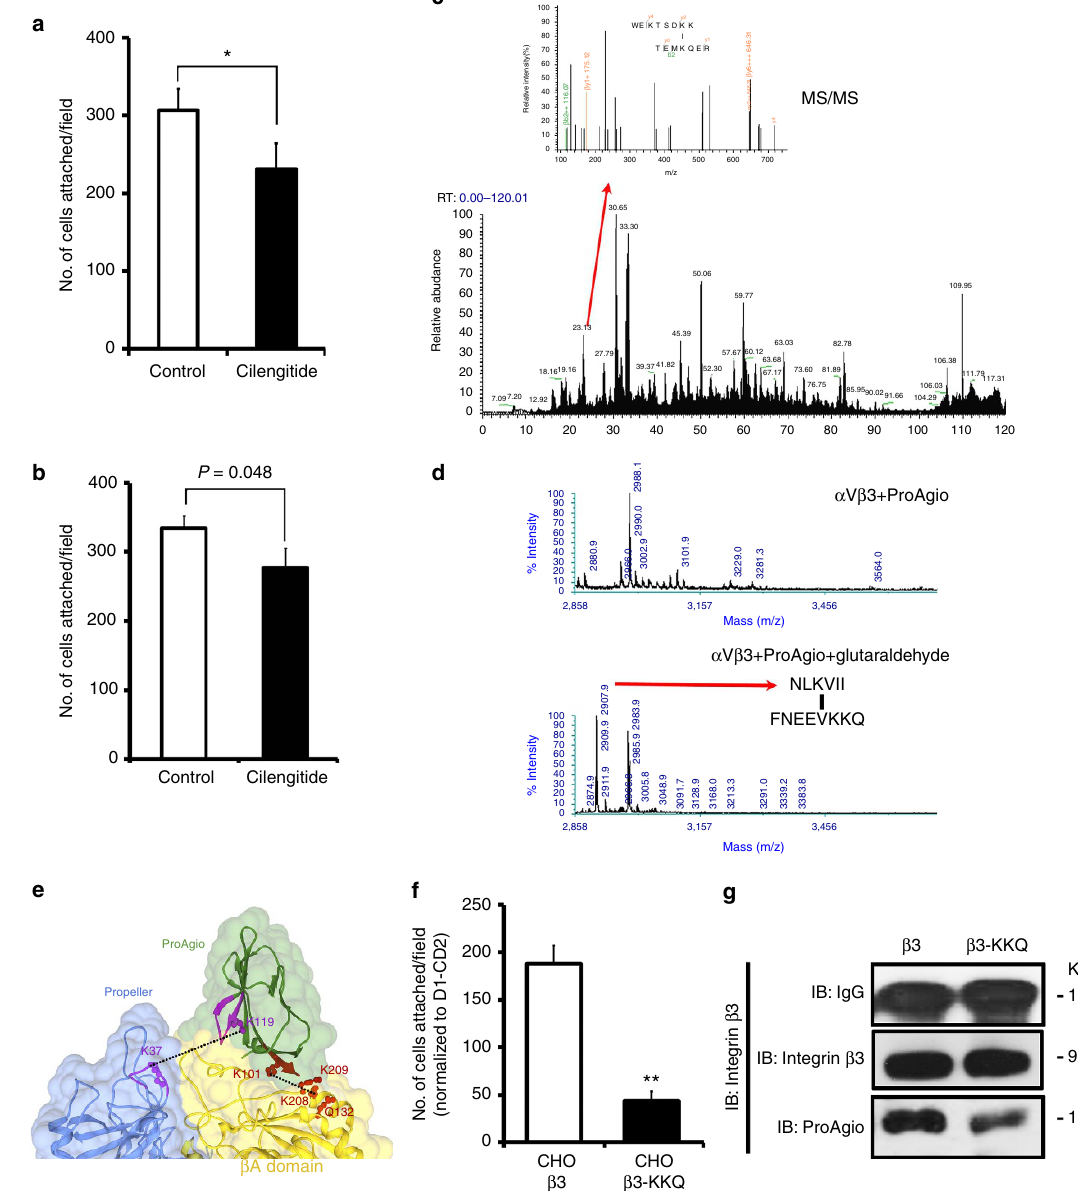
Figure 2 | ProAgio binds to integrin a v b 3 at the designed site. ( a , b ) Attachment of HUVEC cells to ProAgio coated plates. The attachment assays were carried out in the presence of 5 m M of Cilengitide or BSA as control ( a ), or 40 m gml (cid:2) 1 antibody LM609 or IgG as control ( b ). ( c ) The MS spectrum of peptide fragments resultant from trypsin digestion of crosslinks of ProAgio with integrin a v b 3 using BS2G as a crosslinker. The call-out is the enlarged region MS2 (indicated by the arrow) containing ProAgio–integrin crosslinking peak and analysed by MS/MS. The sequence on top is derived crosslinking sequence from MS/MS using pLink. ( d ) The MS spectrum of peptide fragments resultant from trypsin digestion of (Bottom) crosslinks of ProAgio with integrin a v b 3 using glutaraldhyde as crosslinker and (Upper) ProAgio–integrin a v b 3 mix without crosslinking. The deduced sequences of the 2907.9Da peaks from MS/MS analyses are indicated. ( e ) Docking model of ProAgio with integrin a v b 3 using Haddock 2.1 program by introducing the crosslinking restrains. The crosslinks are indicated by dotted lines. The mutation sites of the integrin b 3 are indicated in red. ( f ) Attachment of CHO cells with expression of integrin a v b 3 wild type or the mutant ( b 3-KKQ) to ProAgio/Vitronectin coated plates. The cell attachment to ProAgio are normalized to cell attachment to D1-CD2. ( g ) Co-immunoprecipitation of b 3 or mutant ( b 3-KKQ) with ProAgio (IP:integrin b 3) from the HUVEC cell lysate was examined by immunoblot (IB:ProAgio). The cells were treated with 5 m M ProAgio for 6h before the extracts preparation. IB:IgG indicate the amounts antibody used in IP. Immunoblot of integrin b 3 (IB:integrin b 3 ) indicates amount of b 3 was precipitated down in the co-IPs. Error bars in a , b and f are s.d. from measurement